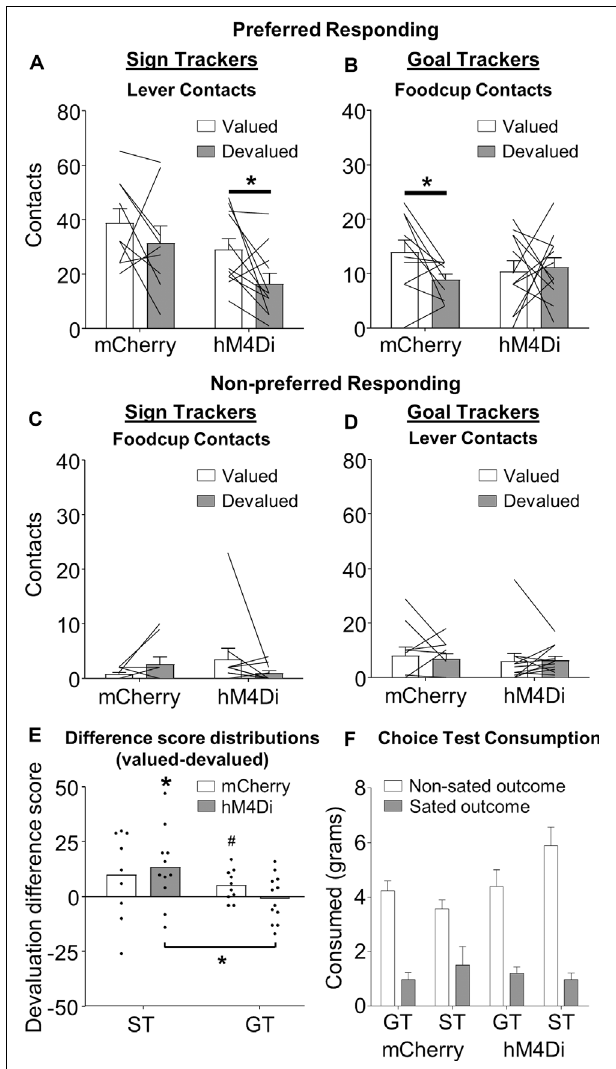
FIGURE 2 | Outcome devaluation in sign- and goal-tracking rats. Data represent individual subjects (line) and group averaged (bars) for (A,B) preferred responding (ST: lever contact, GT: foodcup contact) and (C,D) non-preferred responding (ST: foodcup contact, GT: lever contact), + SEM. A priori planned comparisons reveal that (A) hM4Di ( t (10) = 2.582, * p < 0.05), but not mCherry ( t (8) = 1.495, p = 0.173), ST rats show devaluation effect (difference between valued and devalued) for lever directed behavior. (B) mCherry ( t (9) = 2.273 * p < 0.05), but not hM4Di ( t (11) = 0.270, p = 0.792), GT rats show devaluation effect for foodcup directed behavior. No interactions were observed for non-preferred responding. (E) Population distributions of devaluation difference scores (valued preferred responding–devalued preferred responding). ST hM4Di population distribution was significantly shifted above zero and significantly different than the GT hM4Di population distribution (* p < 0.05, # p = 0.07). (F) Consumption during the choice test following outcome devaluation is represented as a function of tracking and viral